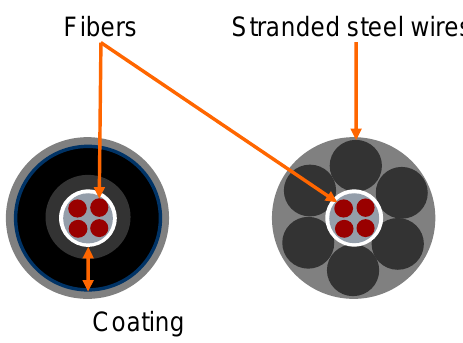
Figure 10. Cable structure and measuring principle. Schematic display of different cable types. Fibers Stranded steel wires